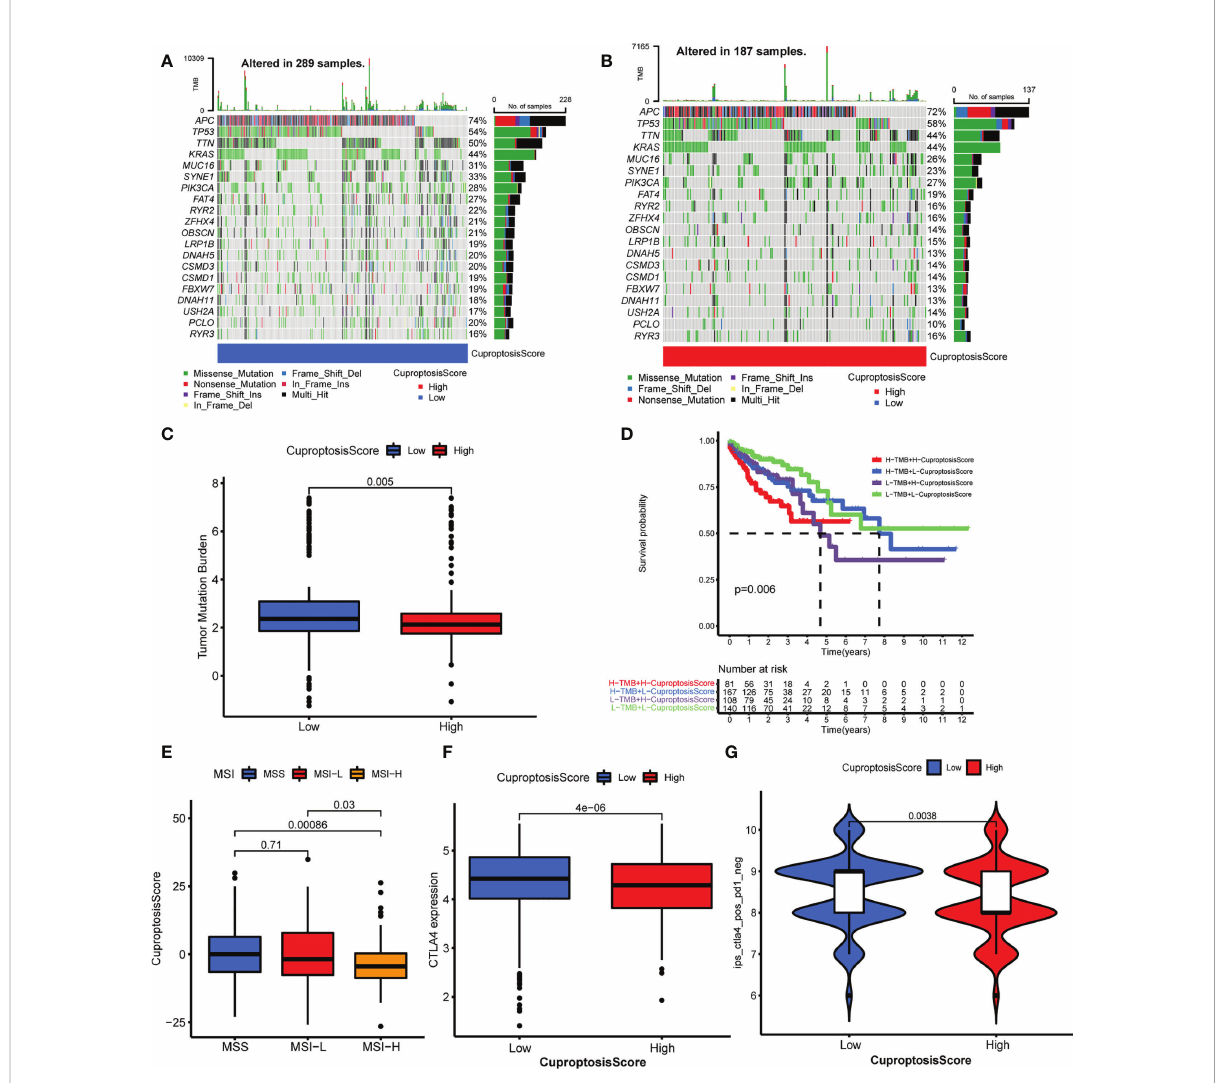
FIGURE 6 Relationship of cuproptosis patterns with tumor somatic mutation and immunotherapy. (A, B) The waterfall plot of tumor somatic mutation of low CuproptosisScore group (A) and high CuproptosisScore group (B) . (C) The TMB of high and low CuproptosisScore group. (D) The Kaplan – Meier curves of overall survival in different groups of TMB combination with CuproptosisScore. (E) The CuproptosisScores of samples with MSS, MSI-L, and MSI-H. (F) CTLA4 expression of the two CuproptosisScore groups. (G) IPS of anti-CTLA4 drug in the two CuproptosisScore